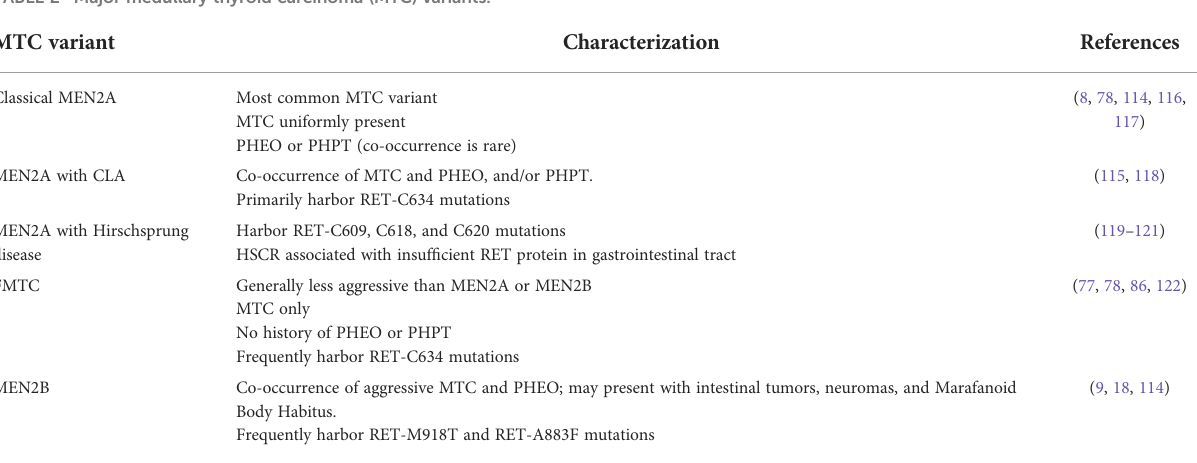
TABLE 2 Major medullary thyroid carcinoma (MTC)